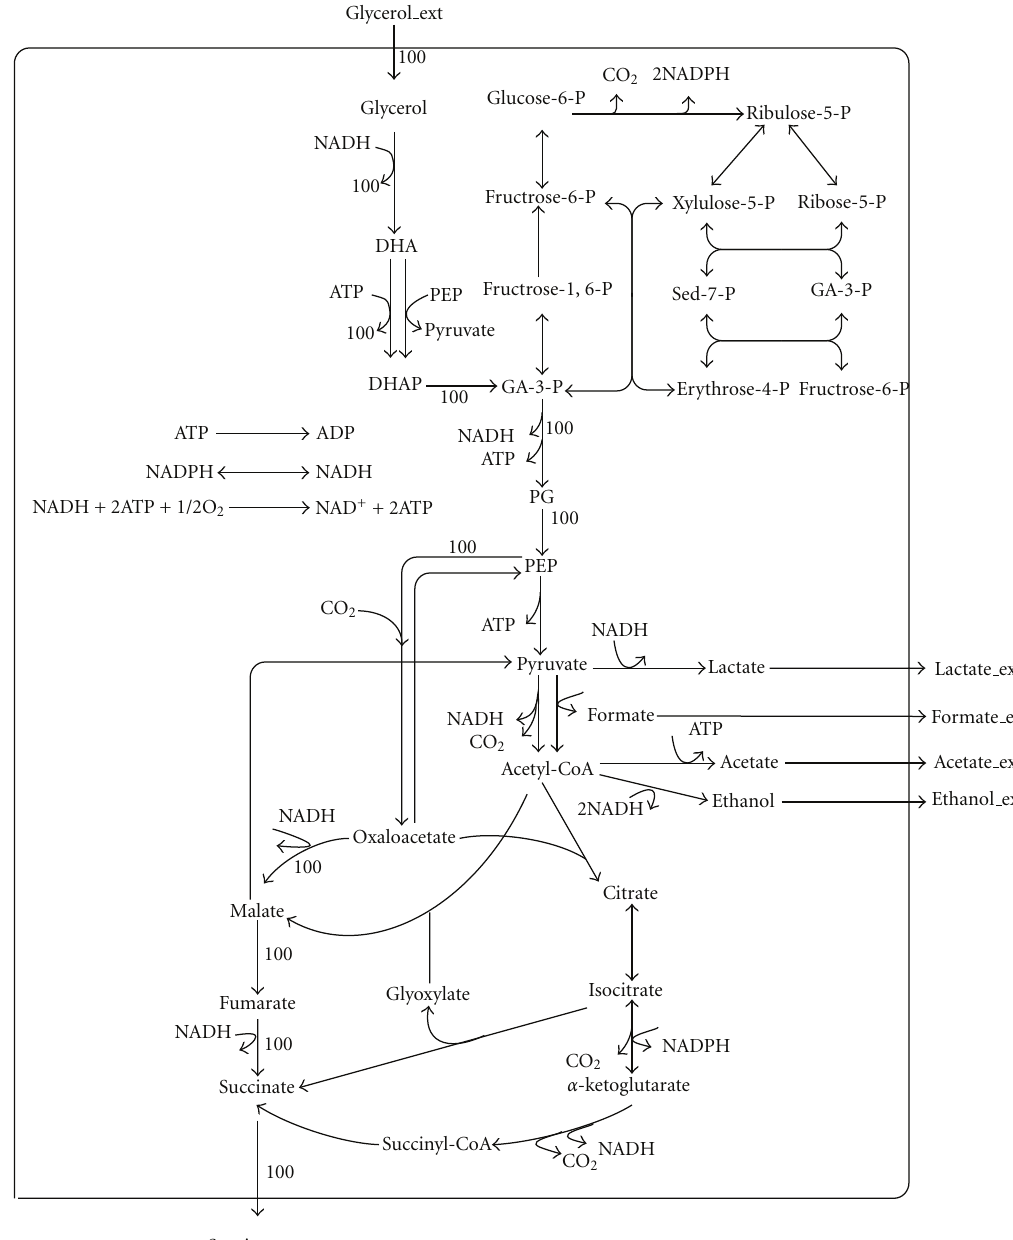
Figure 3: The optimum flux distribution of glycerol metabolism for succinate production in E. coli under anaerobic conditions when only ATP-dependent DHA kinase plays a